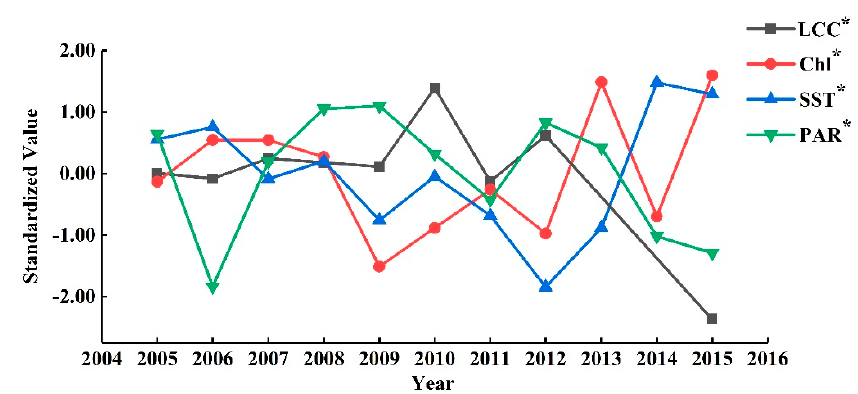
Figure 5. Standardized LCC and corresponding environmental parameters of the SW site.